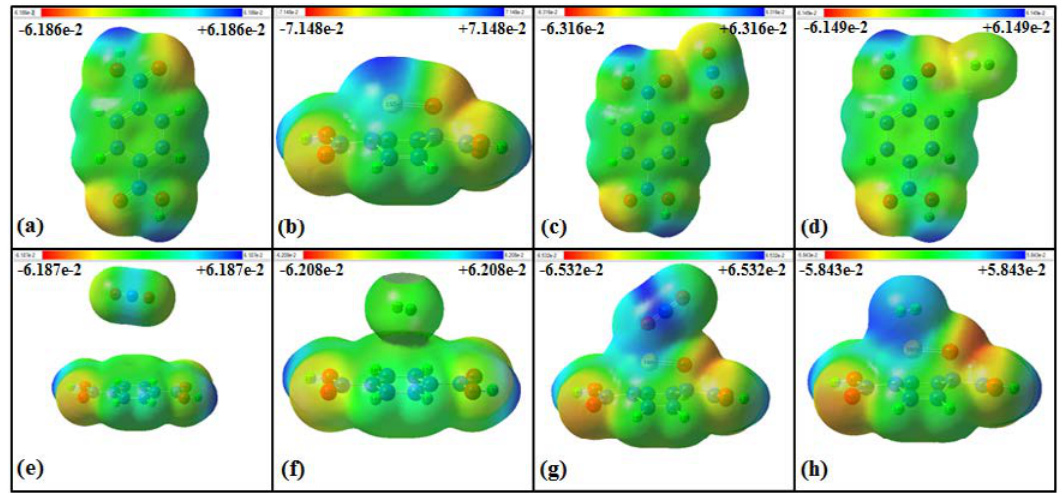
Fig. 7: The MEP of all systems; (a) pristine H